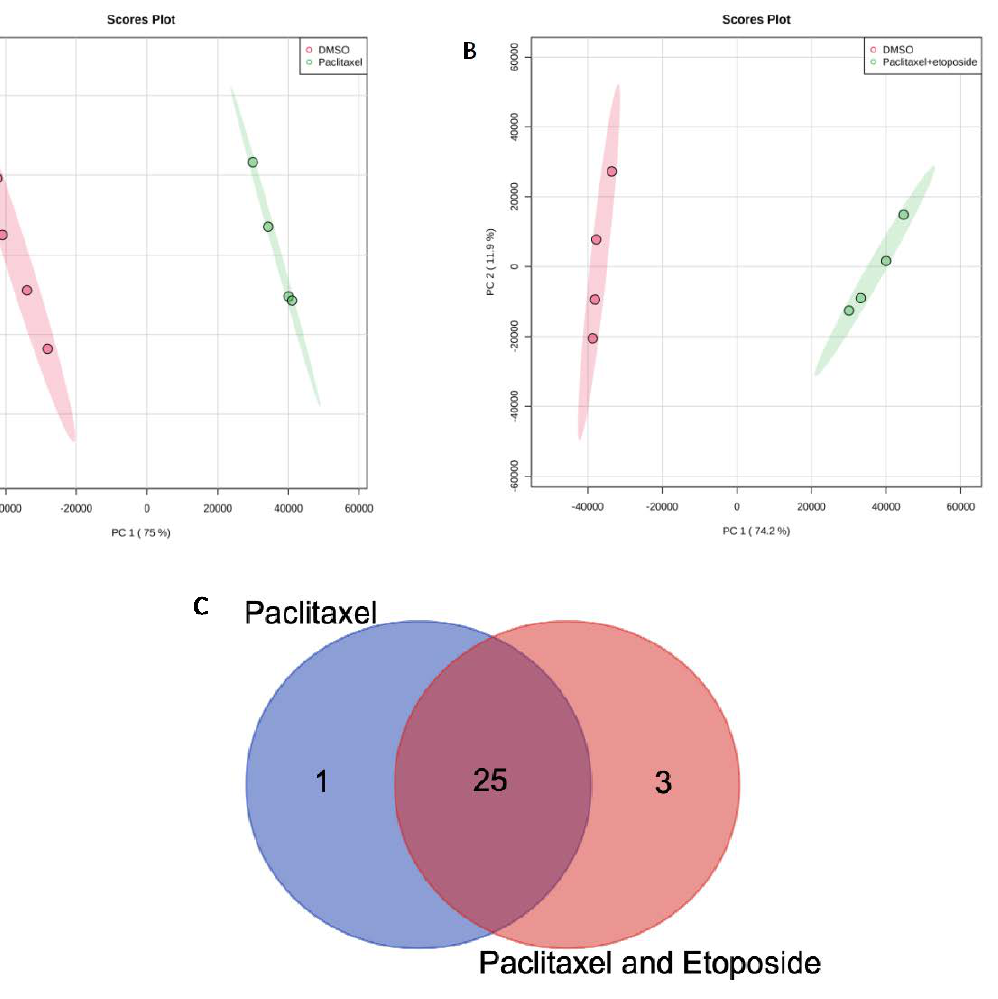
Figure 2. Principal component analysis (PCA) for ( A ) DMSO with paclitaxel 4.2 nM; ( B ) DMSO with (paclitaxel 4.2 nM + etoposide 10 µg/mL); ( C ) Venn diagram comparing metabolites’ response to treatment with paclitaxel 4.2 nM or paclitaxel 4.2 nM + etoposide 10 µg/mL in U87 cell line. Table 2. Metabolites that responded to drug treatments according to Venn diagram comparison in U87 cell line.